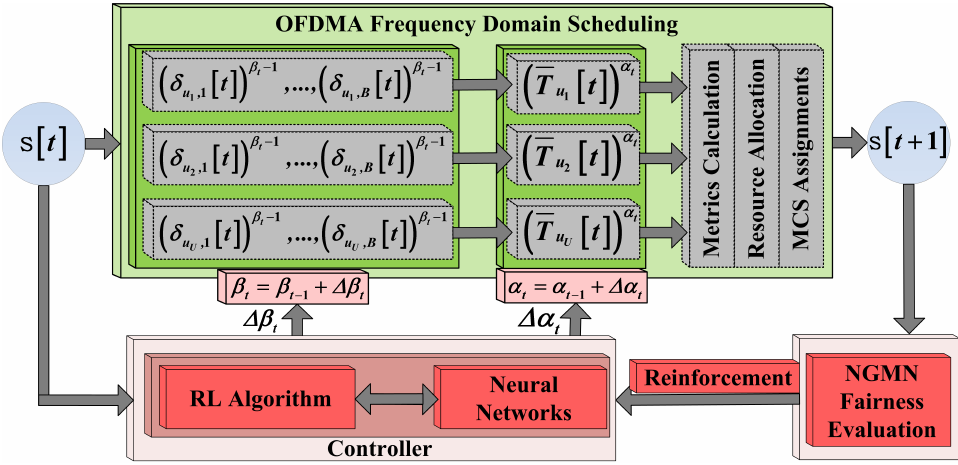
Figure 2. Proposed